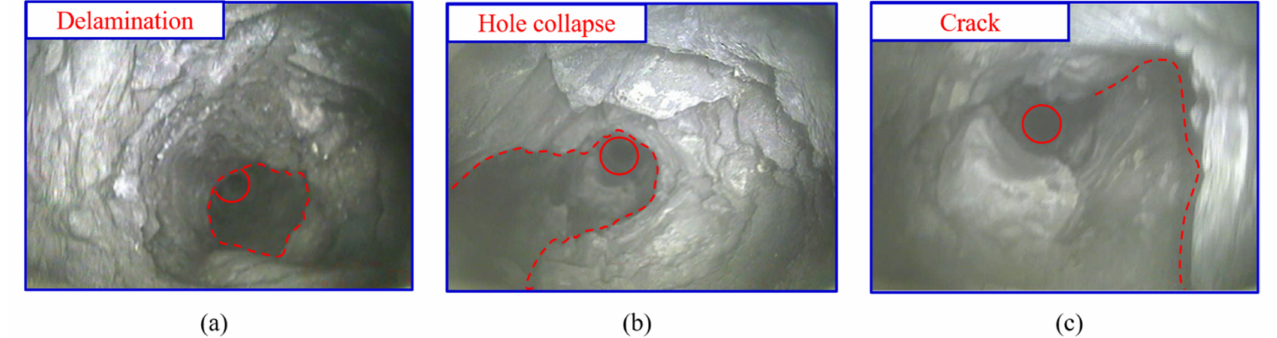
Figure 8. Borehole peep of top coal. ( a ) Delamination occurred in the borehole. ( b ) Collapse occurred in the borehole. ( c ) Cracks occurred in the borehole.